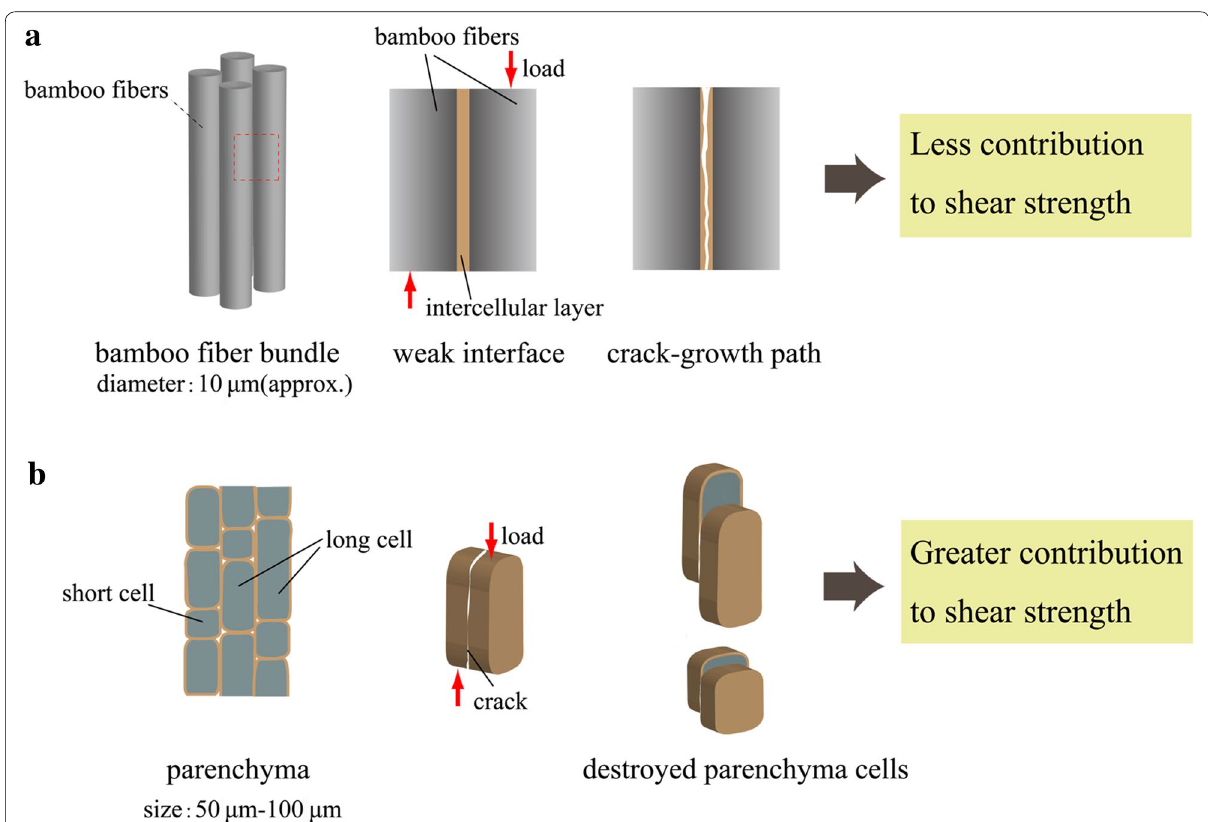
Fig. 8 Schematic drawing of function of different kinds of cells on bamboo shear strength: a fiber cells, b parenchyma